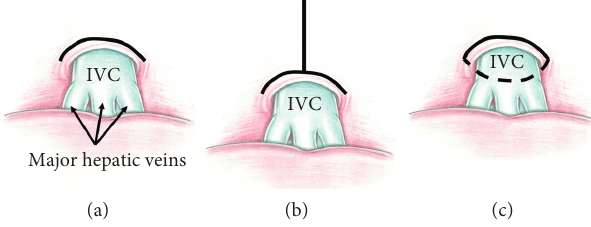
Figure 2: Types of diaphragmotomy: (a) transverse dia- phragmotomy, (b) T-shaped diaphragmotomy, and (c) circular diaphragmotomy.